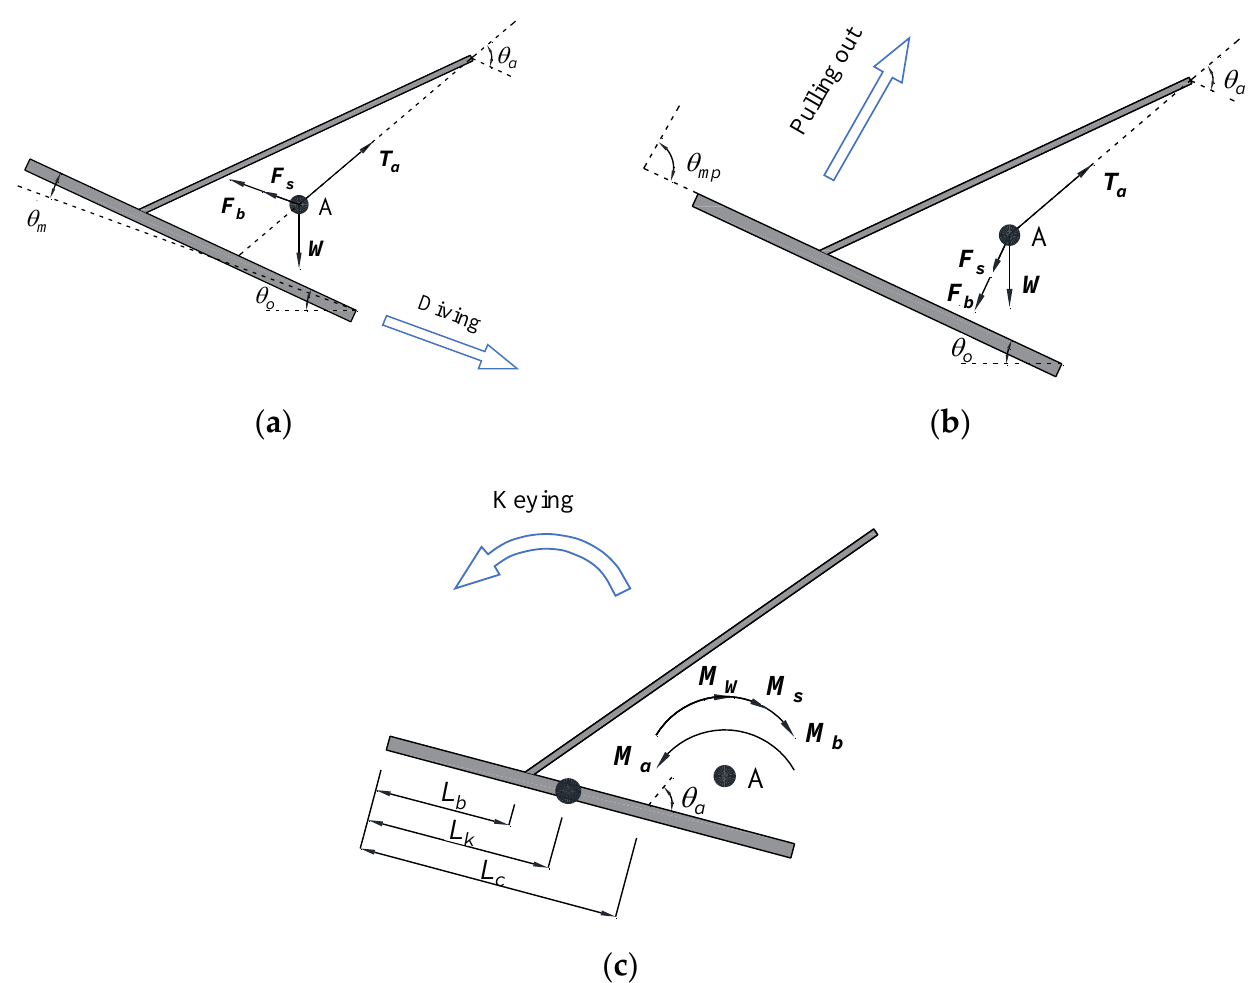
Figure 3. Definition of drag anchor behaviors and mechanical model: ( a ) Diving; ( b ) Pulling out; ( c ) Keying.